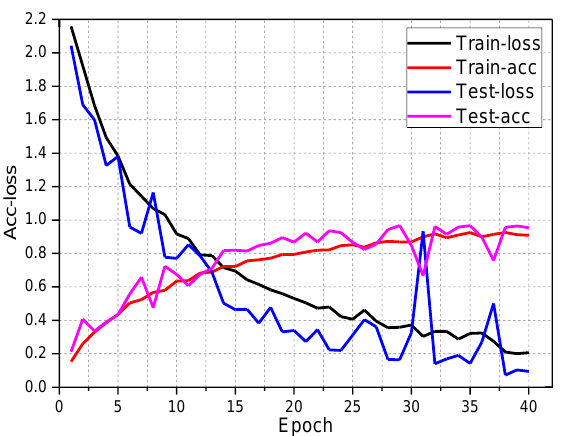
Figure 13. The training and testing process of the artificial neural network with back propagation (ANN-BP) with the structure 784 – 200 – 64 – 32 – 9.